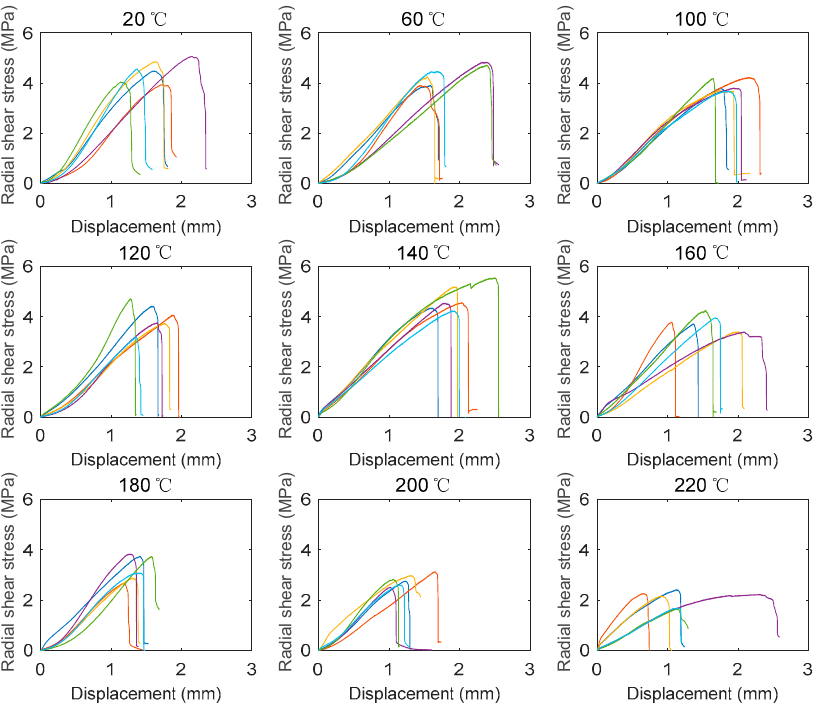
Figure 8. Radial shear stress–displacement at different elevated temperatures.